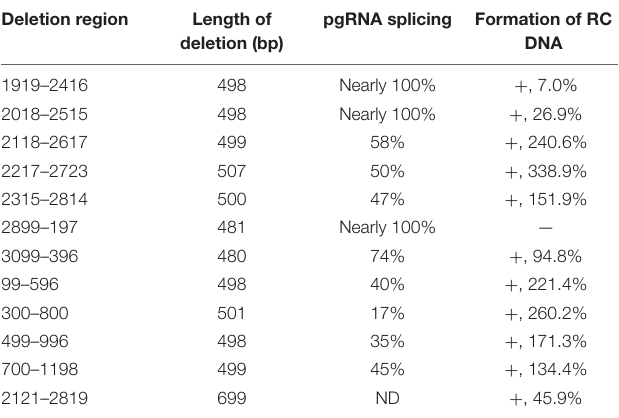
TABLE 1 | Influence of deletion on the formation of RC DNA. Deletion region Length of deletion (bp)